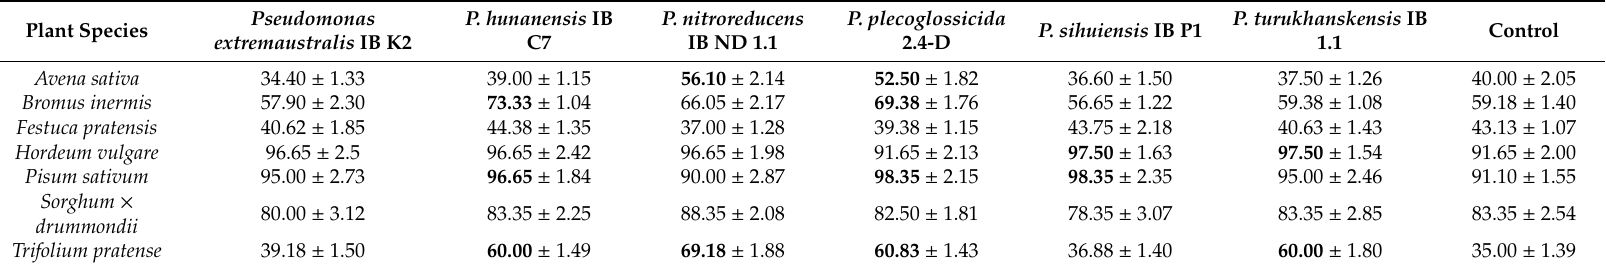
Table 5. E ff ect of inoculating seeds with strains of Pseudomonas bacteria on percentage seed germination in Petri dishes after 7 days.